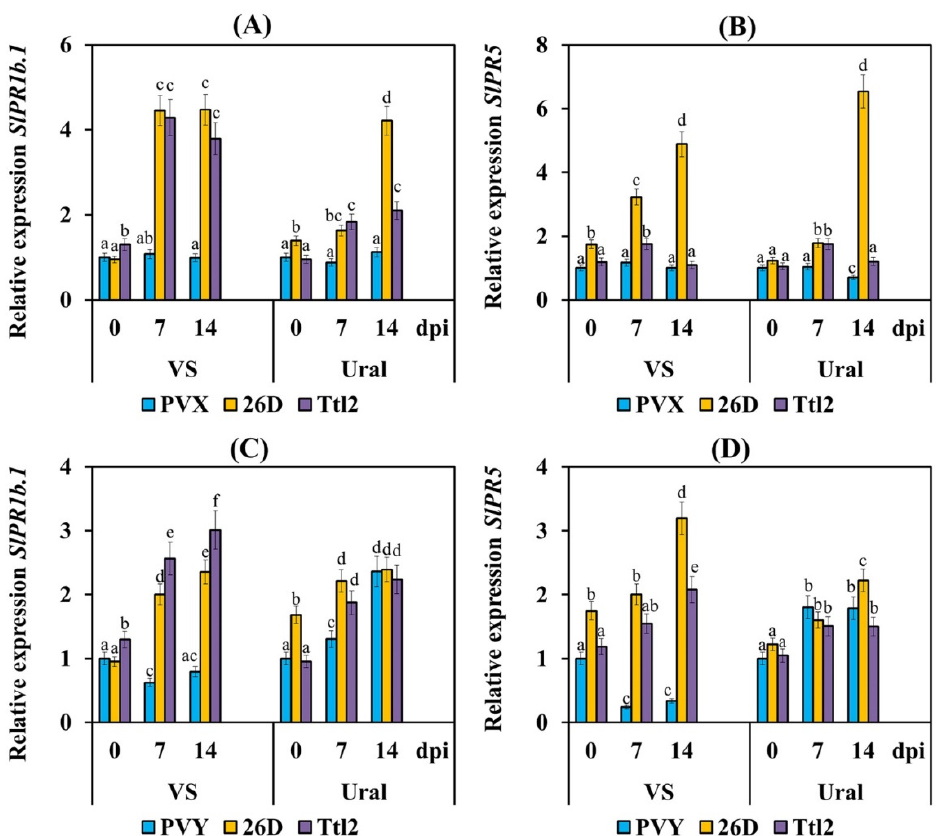
Figure 6. Influence of the endophytic strains B. subtilis 26D and B. subtilis Ttl2 on the relative expression of the SA-dependent genes SlPR1b.1 ( A , C ) and SlPR5 ( B , D ) in tomato plants of the varieties Volovye Serdtse (VS) and Ural infected with PVX ( A , B ) and PVY ( C , D ). The expression values were normalized to the housekeeping gene of tomato plants, SlACT, as an internal reference. The samples are indicated as follows: 0 dpi, control non-infected plants; PVX, plants infected with potato virus X; PVY, plants infected with potato virus Y; 26D, plants treated with B. subtilis 26D; Ttl2, plants treated with B. subtilis Ttl2. The figures present means ± SE (n = 6). The treatments marked with different Latin letters in one cultivar are statistically different from the control ones (0 dpi, not infected with viruses and not treated with bacteria) in each time-point, according to the LSD test ( p ≤ 0.05).